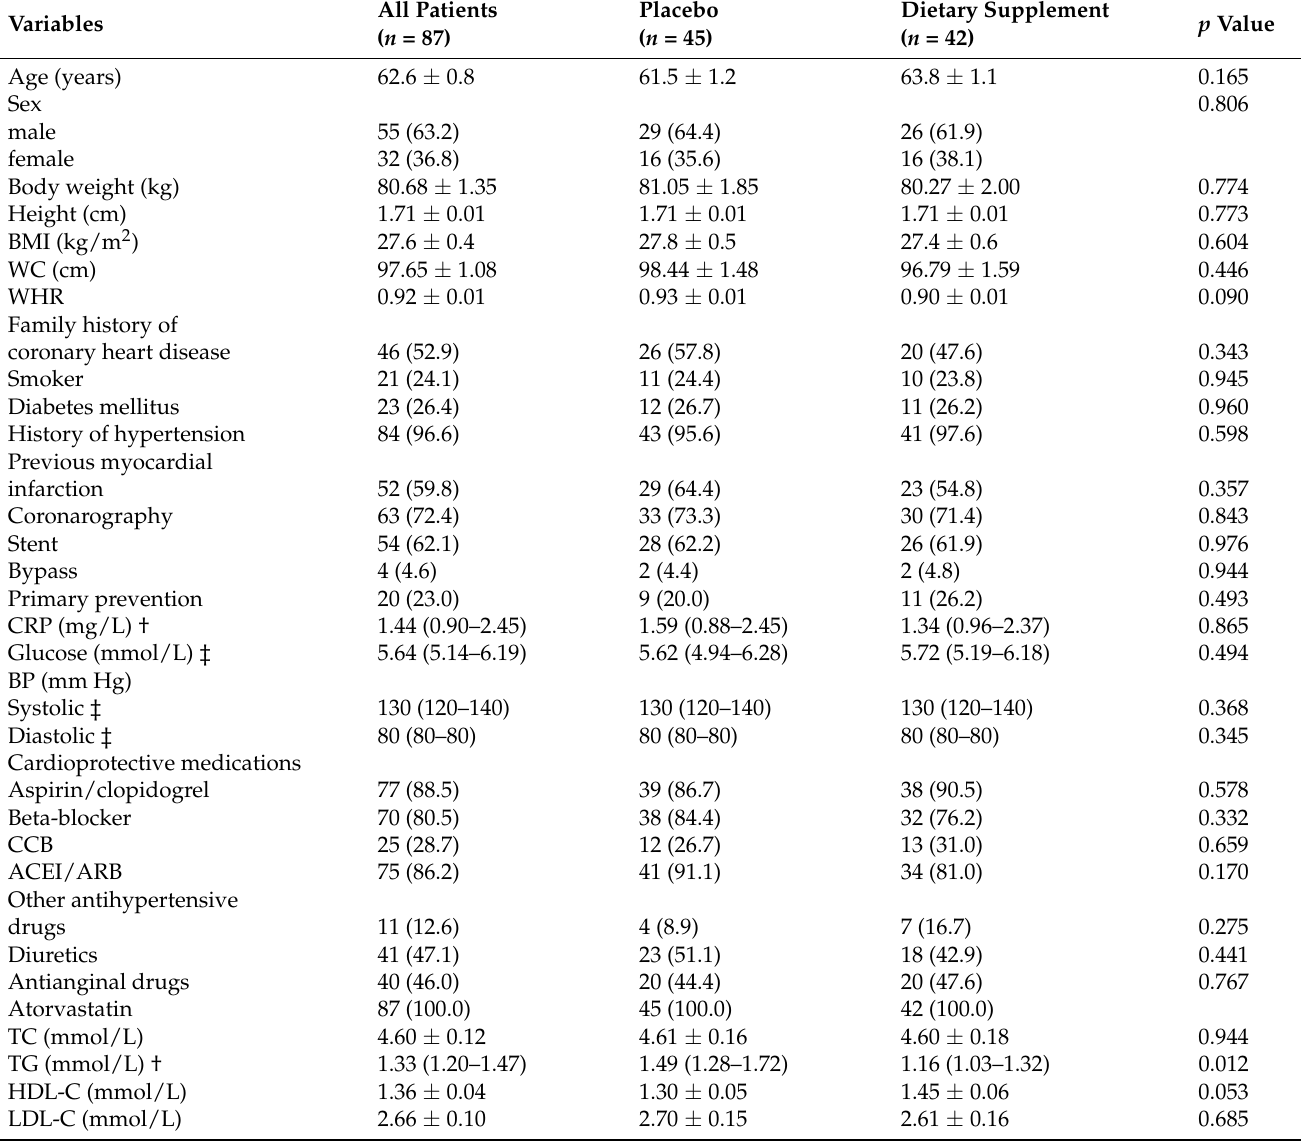
Table 1. Baseline characteristics of the study